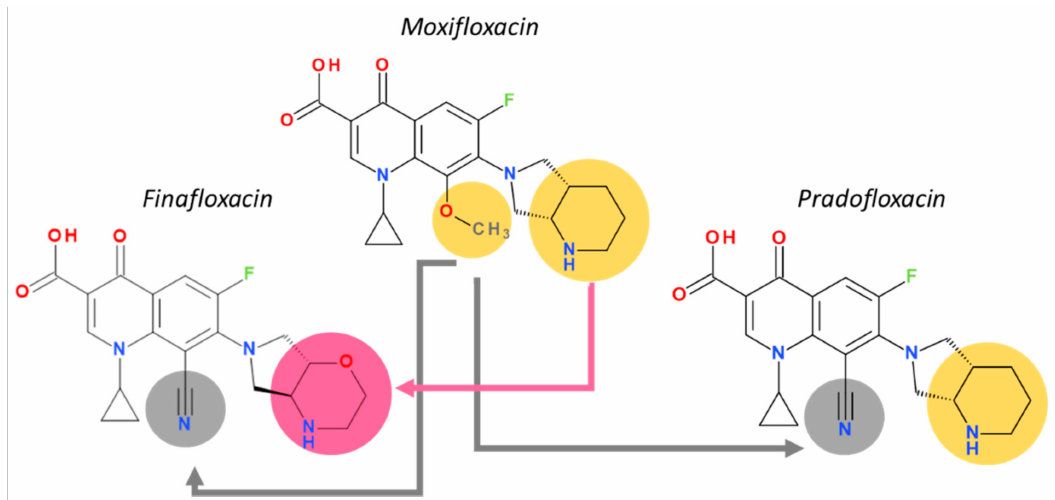
Figure 7. Relevant structural elements to the antibacterial activity of moxifloxacin (C7—pyrrolo-piperidinyl, C8—methoxi), pradofloxacin (C7—pyrrolo-piperidinyl, C8—cyano) and finafloxacin (C7—pyrrolo-oxazinyl,